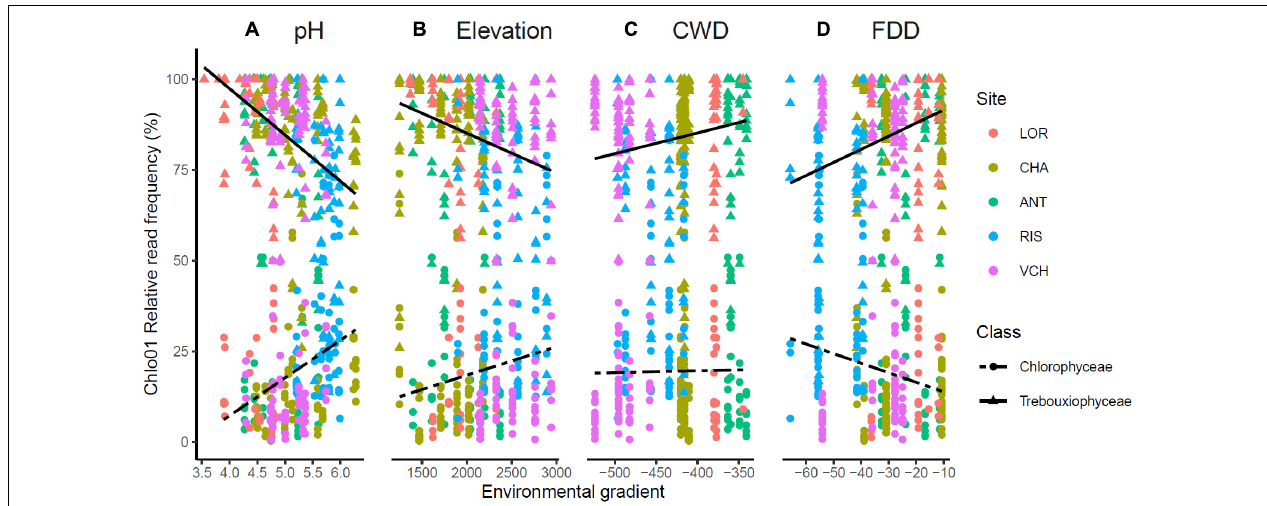
FIGURE 7 | Trebouxiophyceae and Chlorophyceae relative abundance was impacted by soil pH (A) , elevation (B) , CWD (C) , and FDD (D) . The upper lines indicate the tendency of Trebouxiophyceae relative abundance when the environmental (pH, elevation) or bioclimatic (CWD, FDD) values increase. The opposite trend is materialized for the Chlorophyceae by the bottom dashed